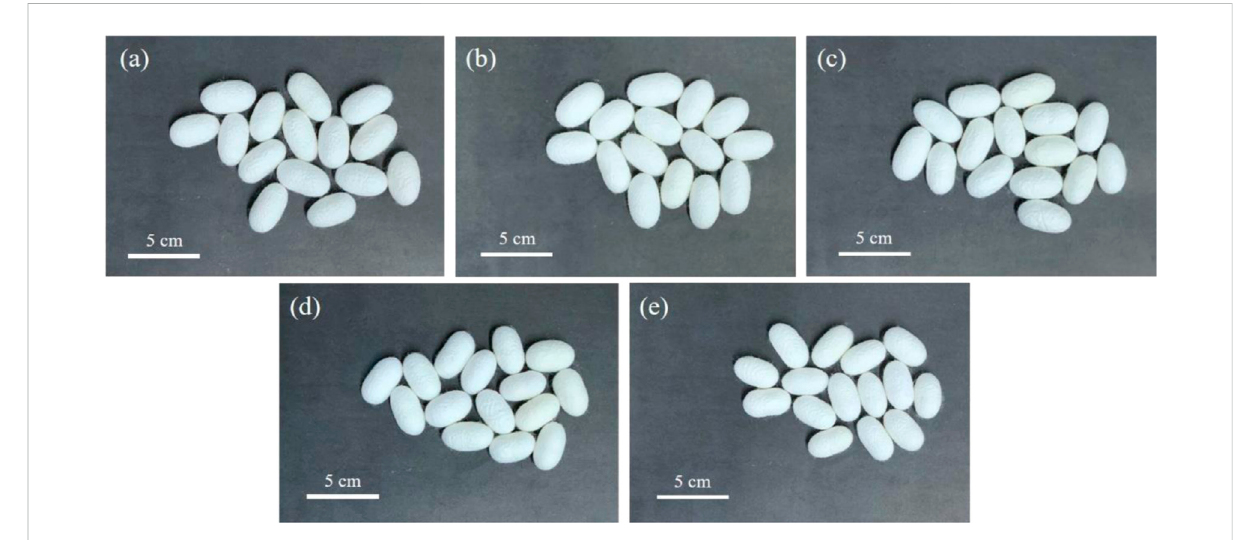
EffectofAMTfeedingontheappearanceofsilkwormcocoons: (A) controlgroup, (B) Mo-0.05 g/Lgroup, (C) Mo-0.1 g/Lgroup, (D) Mo-0.5 g/L group, and (E) Mo-1 g/L